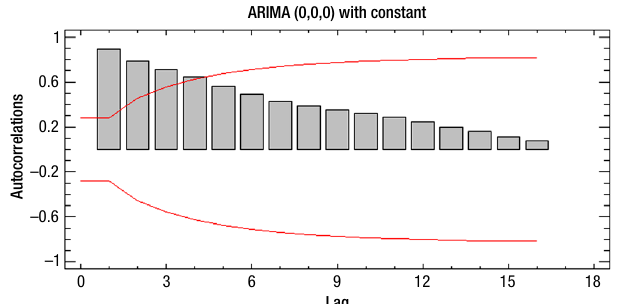
Fig. 13a. Residual autocorrelations for time series of annual Argentinian